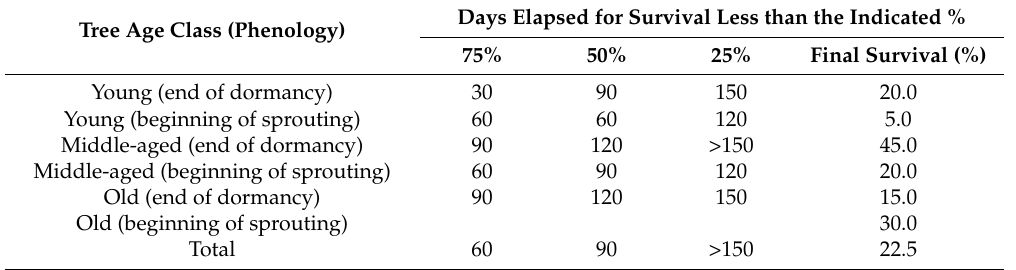
Table 7. Pinus engelmannii graft survival dynamics for each combination of age class of the scion donor tree (DTA) and phenological state of buds (PSB).